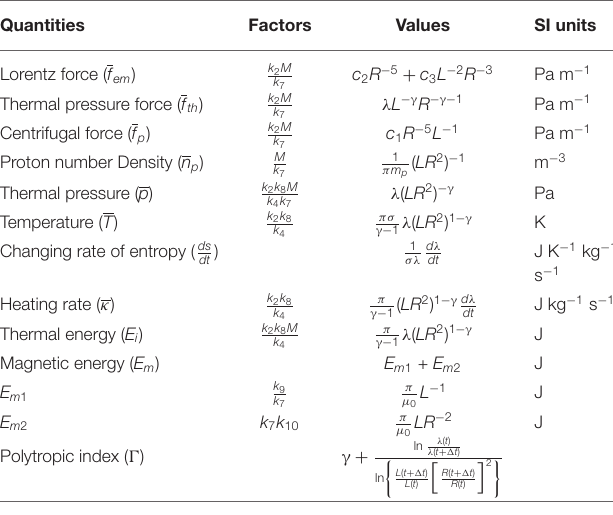
TABLE 1 | List of the derived internal thermodynamic parameters, constants, and coefficients from FRIS model. Internal thermodynamic parameters derived from the model Quantities Factors Values SI units